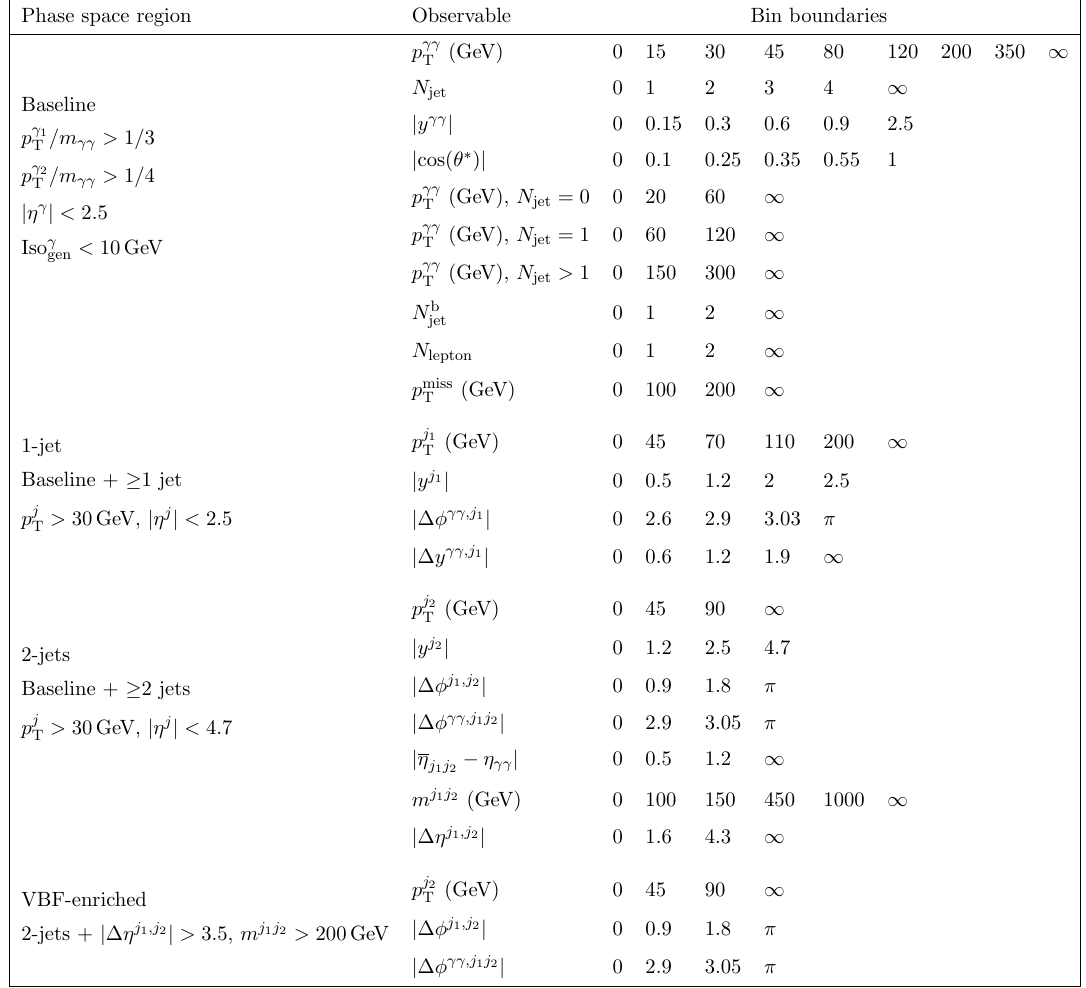
Table 1 . The di(cid:11)erential observables studied with the corresponding bins chosen, grouped by the region of the (cid:12)ducial phase space where the measurements are